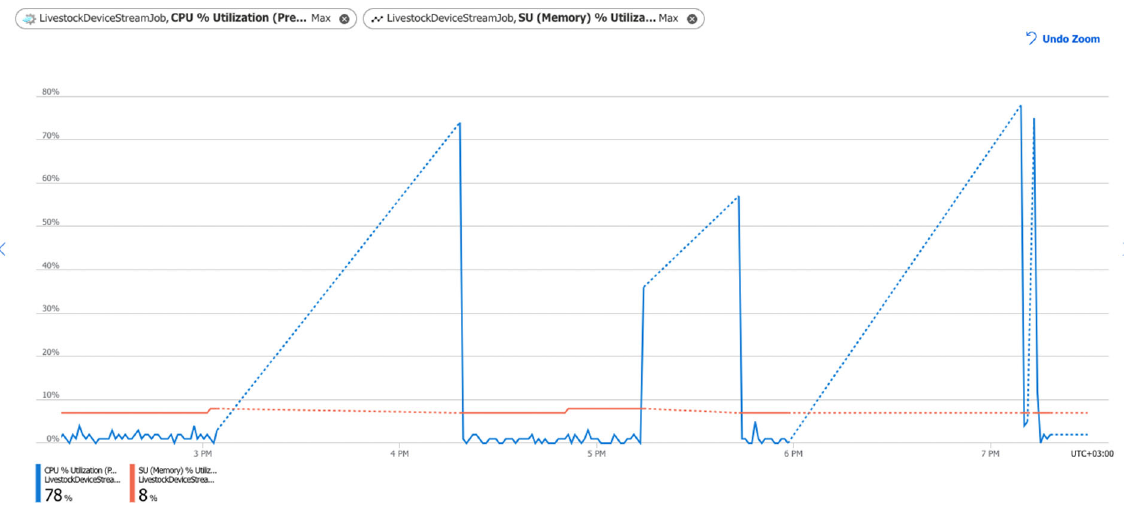
Figure 12. Stream Job Utilization Percentage. The blue line shows the percentage of CPU Utilization. The Red line shows the percentage of SU Utilization. The dotted line shows that no data is ingested for that period (when IoT devices are in sleep mode).